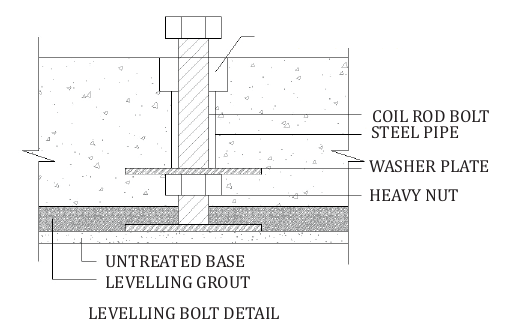
Figure 2. Threaded levelling system